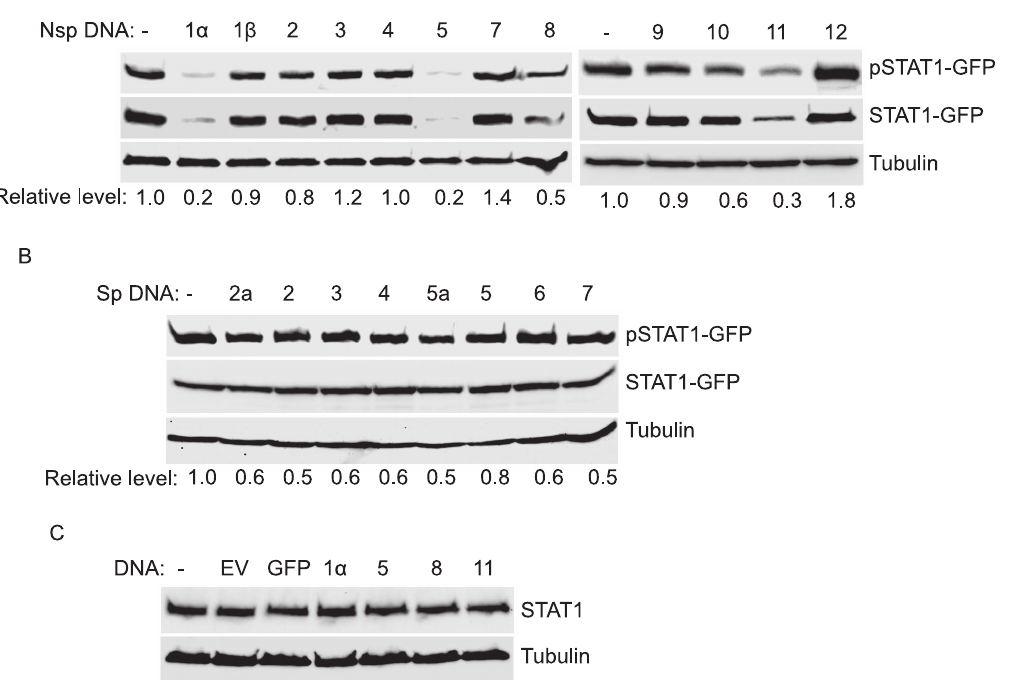
Figure 7. Screening of non-structural and structural proteins of PRRSV VR-2385 in inducing pSTAT1-S727 elevation. A. Screening of VR-2385 non-structural proteins (nsps) 1–12. HEK293 cells were transfected with STAT1-GFP and VR-2385 nsp plasmids. The cells were harvested 48 h after transfection for Western blotting with antibodies against pSTAT1-S727, STAT1 and tubulin. Relative levels of pSTAT1 in comparison with control vector lane are shown as folds below the images. B. Screening of VR-2385 structural proteins (sps) encoded by ORFs 2–7. HEK293 cells were transfected with STAT1-GFP and VR-2385 sp plasmids. Blotting and analysis were conducted similarly as in ‘‘A’’. C . Expression of endogenous STAT1 remains stable in HEK293 cells transfected with PRRSV nsps. The cells were transfected with empty vector, GFP, nsp1 a , nsp5, nsp8 or nsp11 plasmids. Western blotting with antibodies against STAT1 and tubulin was conducted.